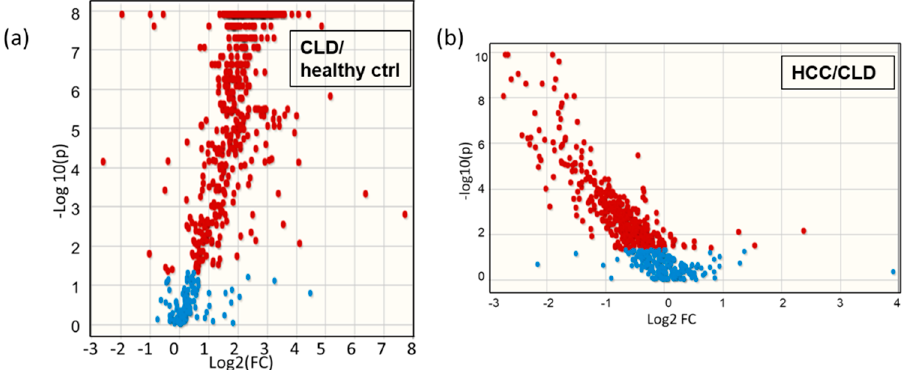
Figure 3. Volcano plots of the pairwise comparison blood lipids. ( a ) Chronic liver disease patients (CLD) versus healthy controls; ( b ) HCC versus CLD subjects. FC indicates fold changes of lipid averages in the two group comparisons.